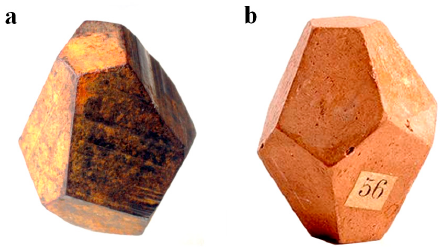
Figure 2. ( a ) Photograph of a limonitised pyrite from Jarapalos, Málaga (Spain), showing a